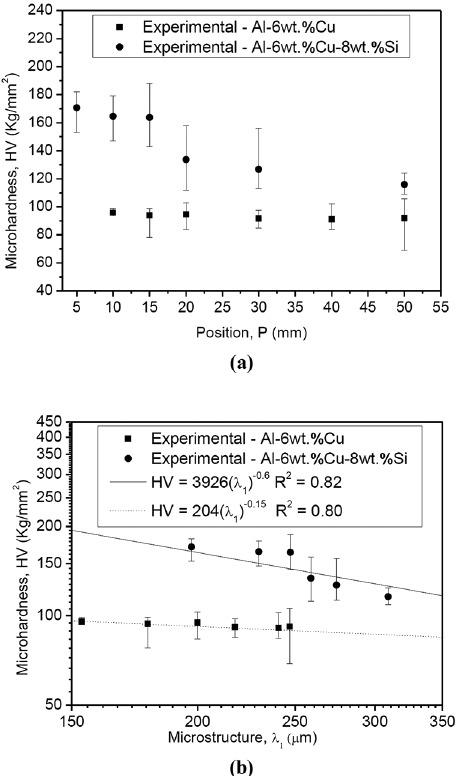
Figure 3 - Microhardness evolution as a function of: ( a ) position in casting, ( b ) the primary dendrite arm sapcing.